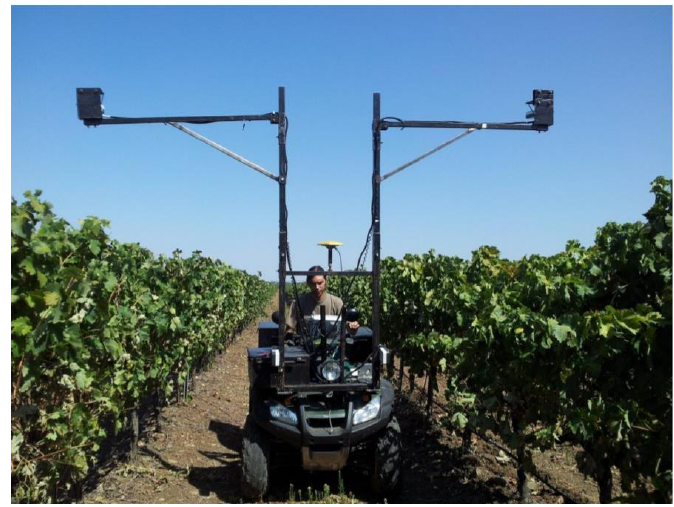
Figure 4. Proximal multispectral sensor (OptRx ACS-430, Ag Leader Technology, Ames, IA, USA) for NDVI mapping of vineyard canopy (reproduced from [57], with permission from SOIL , 2015).